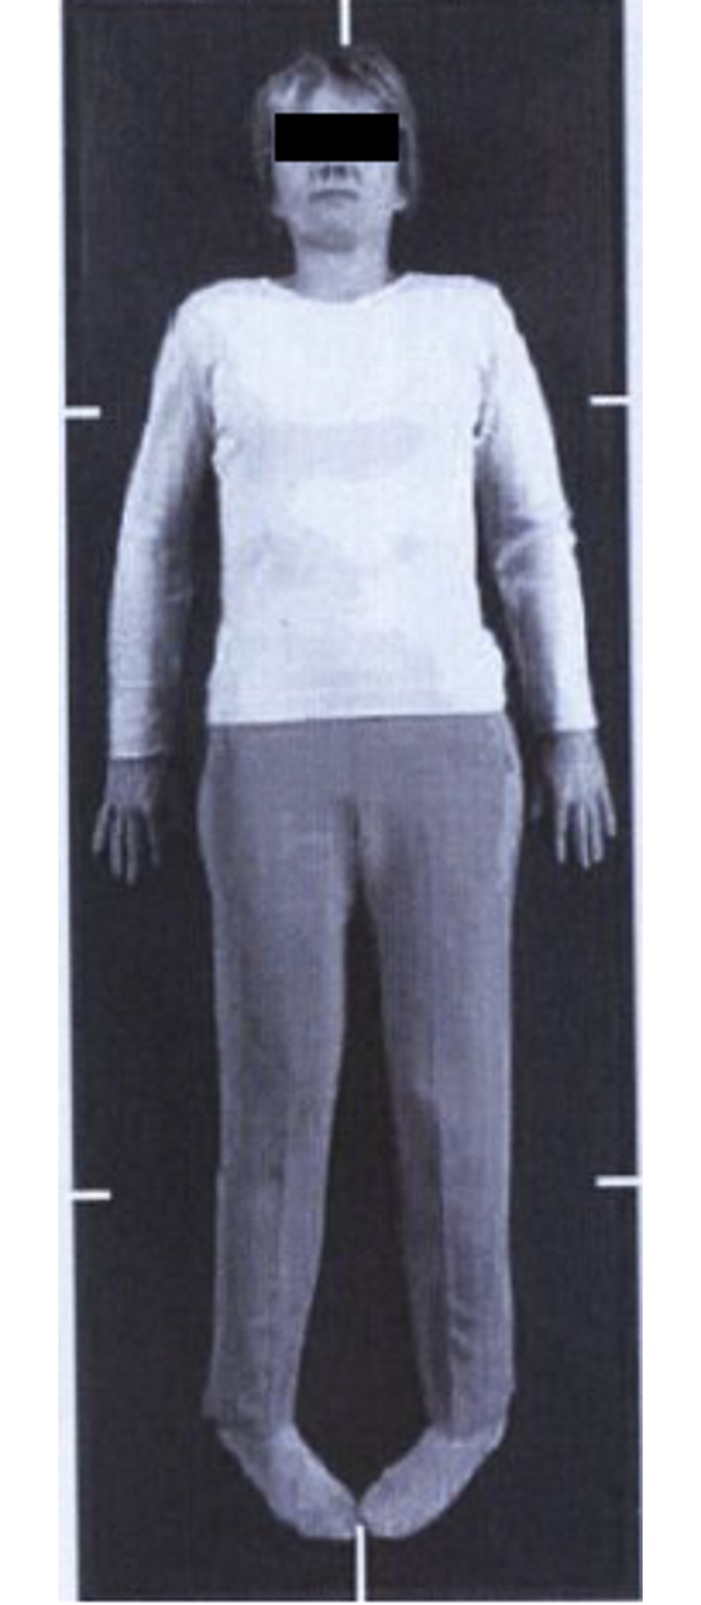
Position of the participant during measurement [42].